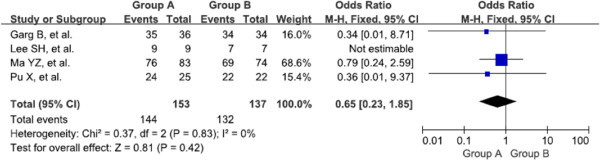
Forest plot of fusion rate of the grafting bone in group A vs. group B.